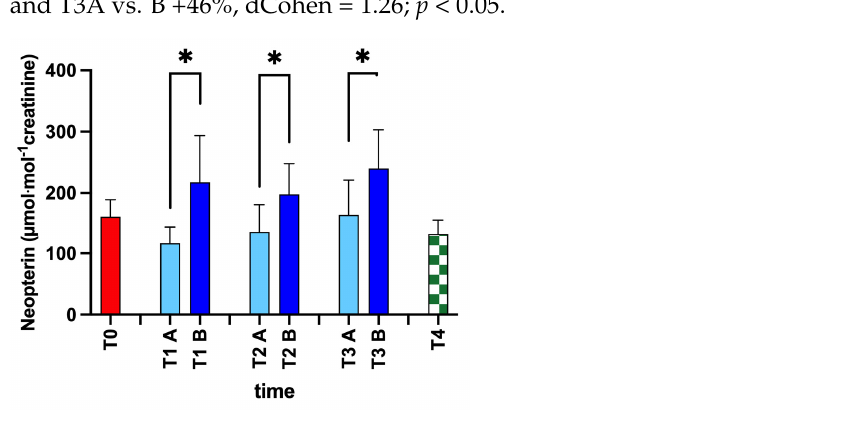
Figure 3. Neopterin changes during the training season. Statistically significant differences symbols: * p < 0.05 .